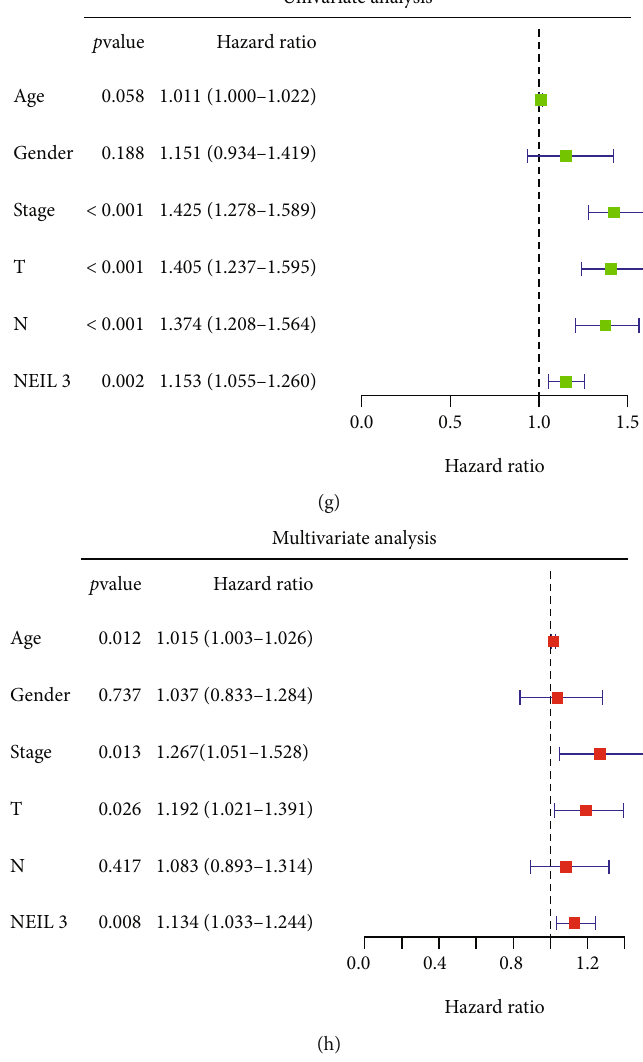
Figure 3: NEIL3 was associated with poor prognostic outcomes in lung cancer patients. Notes: (a – c) association between NEIL3 and patient OS, DSS, and PFI in the TCGA-LUAD cohort; (d – f) association between NEIL3 and patient OS, DSS, and PFI in the TCGA-LUSC cohort; (g, h) univariate and multivariate analyses indicated that NEIL3 was an independent prognostic marker in lung cancer